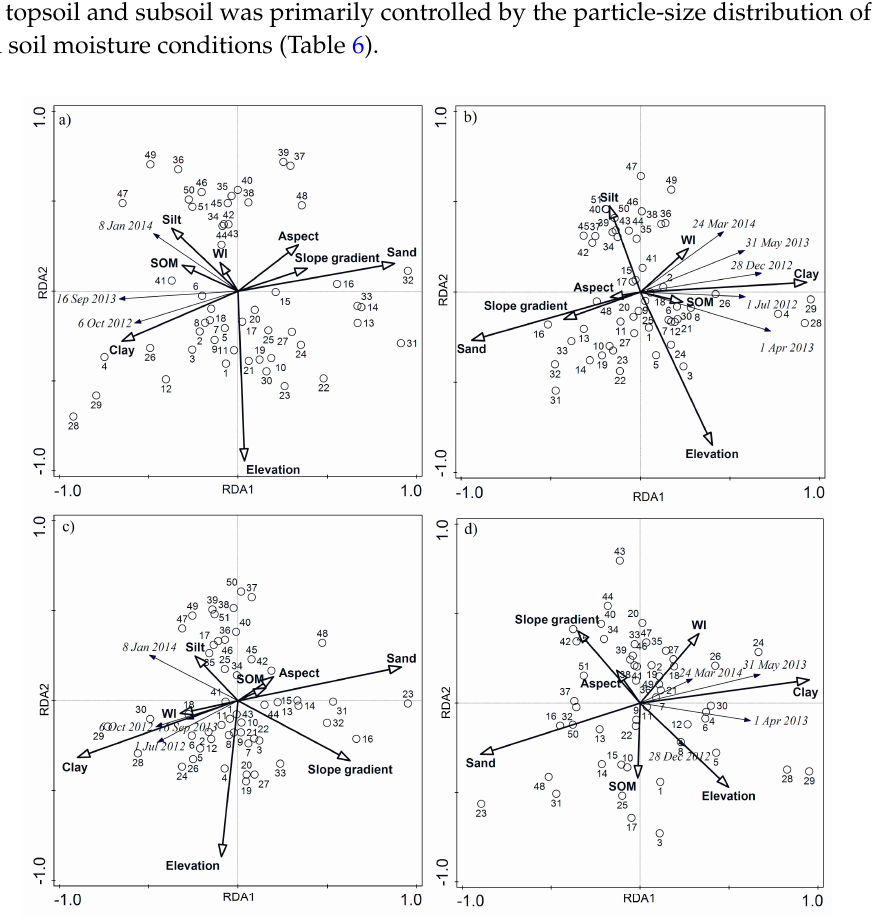
Figure 6. RDA triplot of the soil moisture content data constrained by all environmental variables, scaling 2 (triplot interpretation rules: (1) Projecting an object at right angles on a response or a quantitative explanatory variable approximates the value of the object along that variable; (2) The angles in the triplot between the response and explanatory variables, and between the response variables themselves or the explanatory variables themselves, reflect their correlations). Soil moisture and environmental variables are represented by arrows (thin for soil moisture, thick for environmental variables); samples are shown as circles. The bottom and left ‐ hand axes are for the objects and response variables, the top and right ‐ hand axes are for the explanatory variables. ( a ) wet condition of soil moisture in topsoil layer; ( b ) dry condition of soil moisture in topsoil layer; ( c ) wet condition of soil moisture in subsoil layer; ( d ) dry condition of soil moisture in subsoil layer.